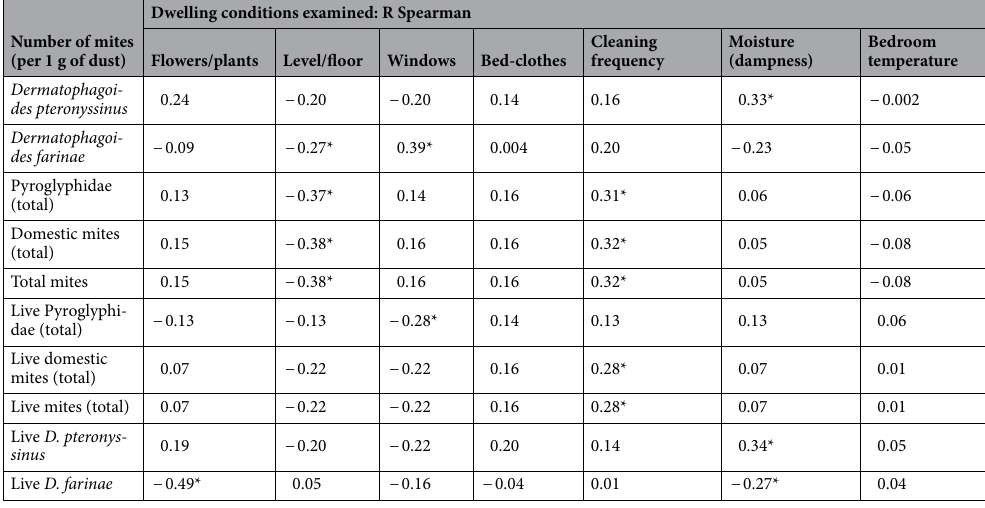
Table 5. Relationships observed between housing conditions and the prevalence of mites in dust samples from dwellings of the examined patients in Bytom (south Poland). Results of the Spearman’s rank correlation test analysis (*p < 0.05). Part III. Flowers/plants: absent [1], present [2]; Level: ground floor [0], first floor or higher (I-IX) [1–9]; Type of window frame: wood [1], PVC [2]; Bedclothes: blankets [1], pillows [3]; Cleaning frequency: times per week; Moisture (signs of dampness): absent [1], present [3]; Bedroom temperature: in centigrade degrees.